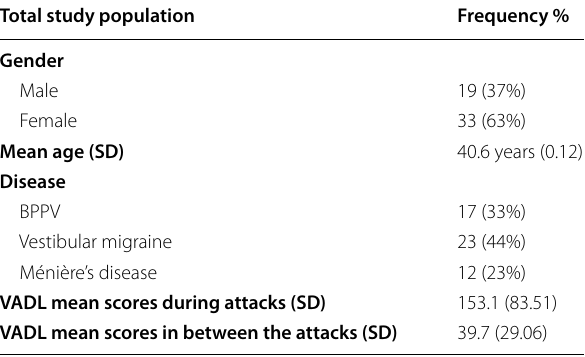
Table 1 Demographic features of the study population Total study